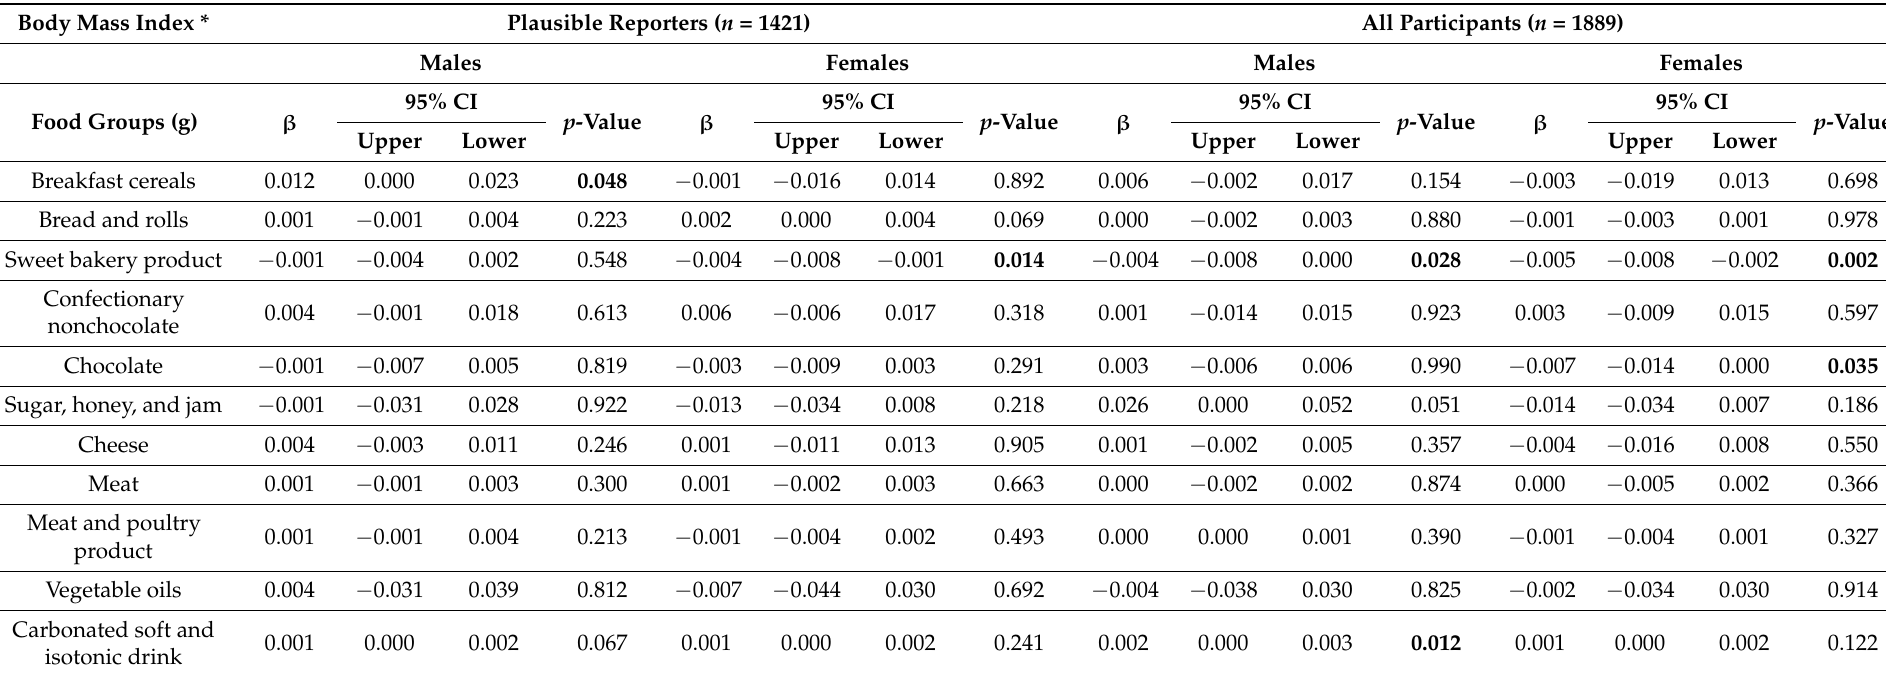
Table 3. The association between BMI and portion sizes (PS) of most ED food using multiple linear regression